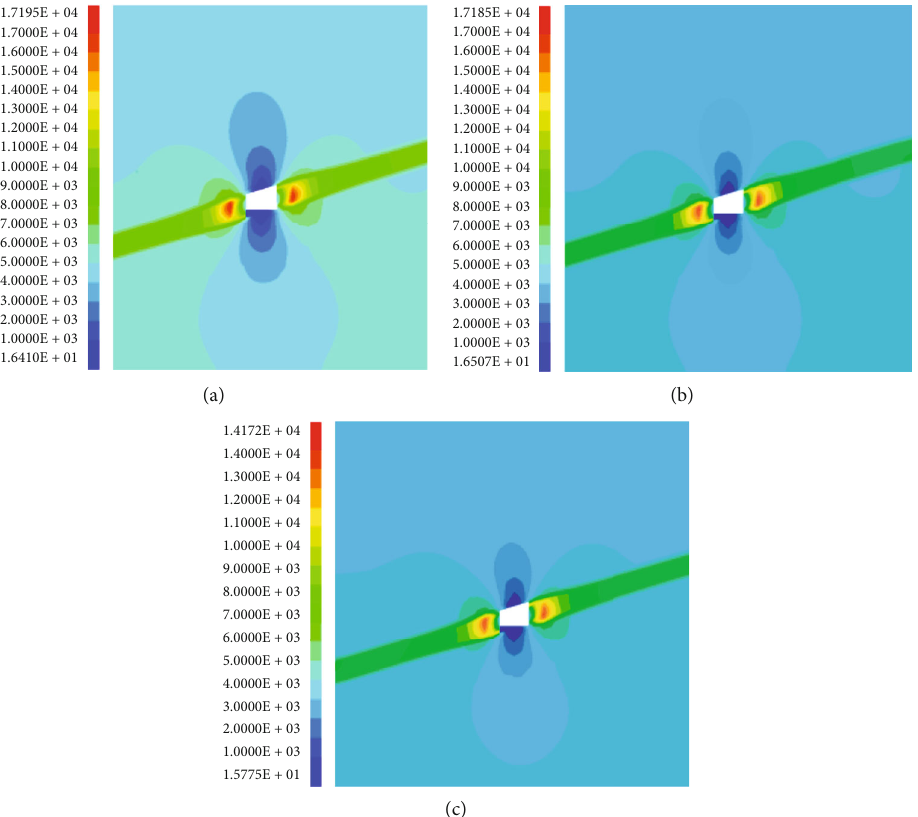
Figure 8: Energy density distribution nephogram of the three scheme. (a) No support. (b) Original support. (c) Combined